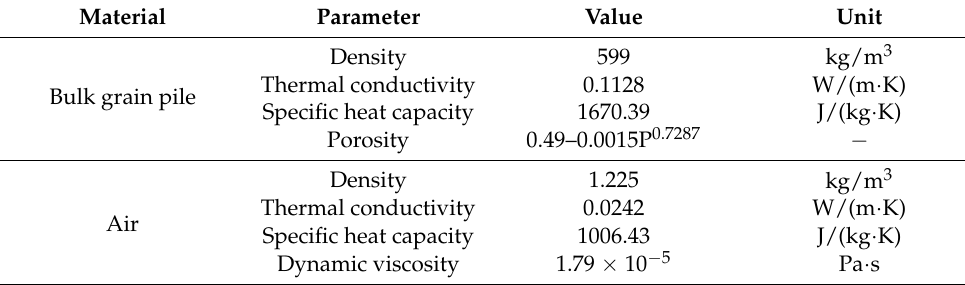
Table 1. Parameters of bulk grain pile and